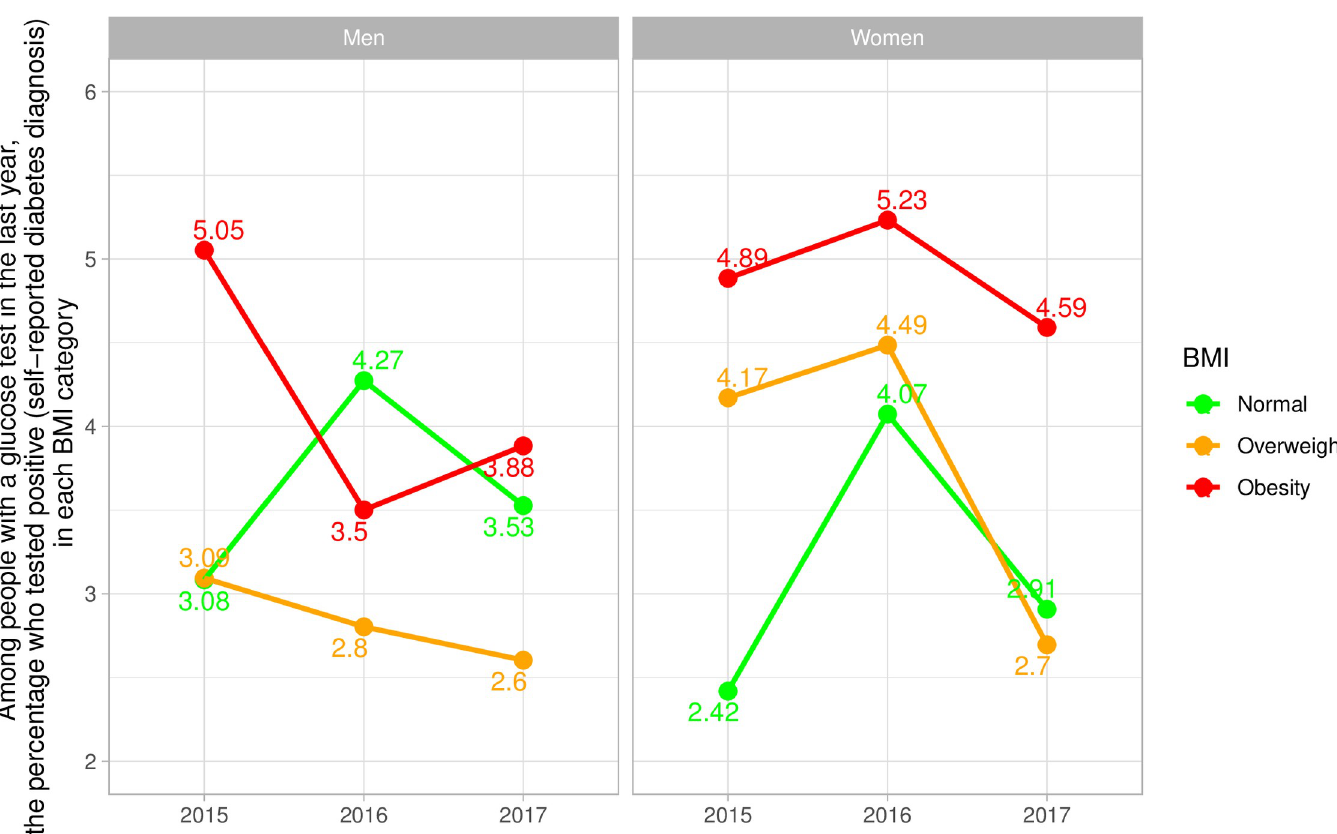
Fig 7. National trends of self-reported diabetes diagnosis among people who had a glucose test by body mass index category stratified by sex.